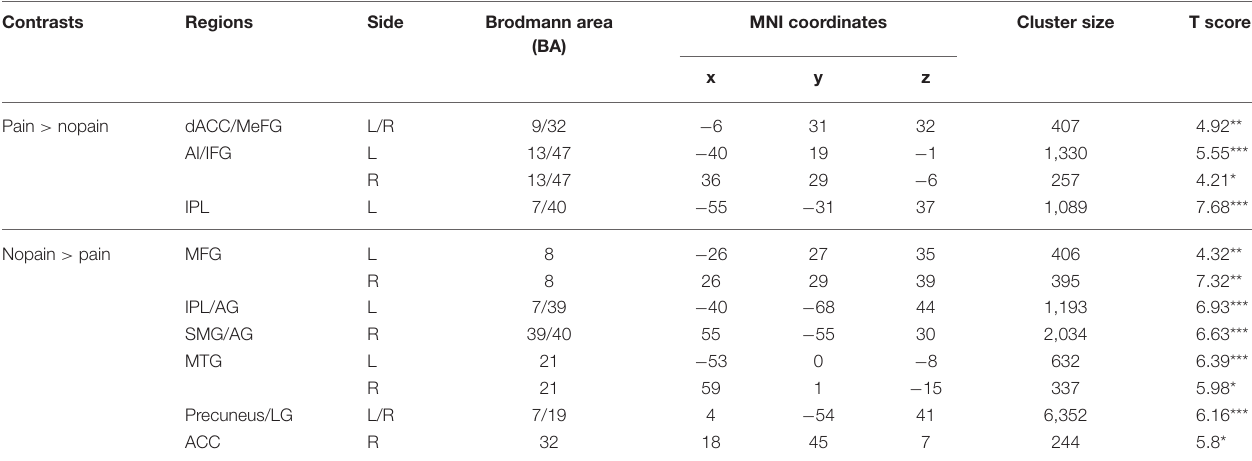
TABLE 3 | Main effects of empathy for